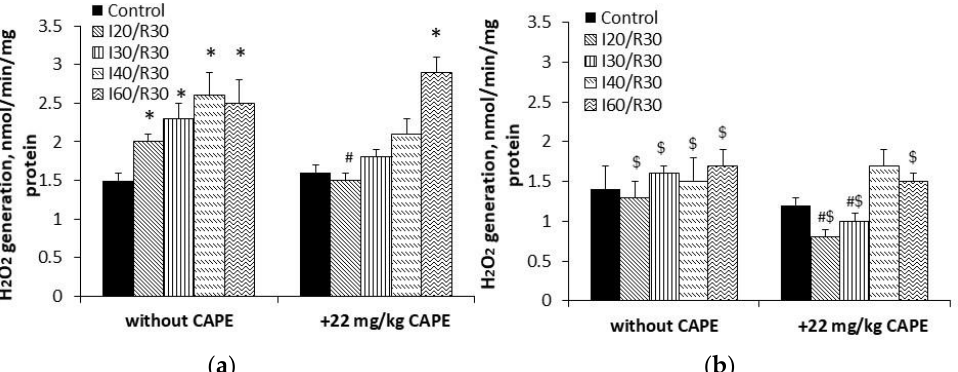
Figure 10. Effect of ischemia/reperfusion and CAPE on H 2 O 2 generation in the kidney mitochondria. The generation of H 2 O 2 in the kidney mitochondria was determined fluorimetrically, as described in the Materials and Methods section (excitation at 544 nm, emission at 590 nm), in the presence of the Complex I inhibitor rotenone (5 µ M) and the Complex III inhibitor myxothiazole (2 µ M). Substrates of succinate 0.4 mM ( a ) and succinate 5 mM ( b ). * p < 0.05 vs. the respective control; # p < 0.05 vs. the group without CAPE; $ p < 0.05 vs. the 0.4 mM succinate group. One-way ANOVA followed by a Fisher’s LSD post hoc test were used to compare the effects.